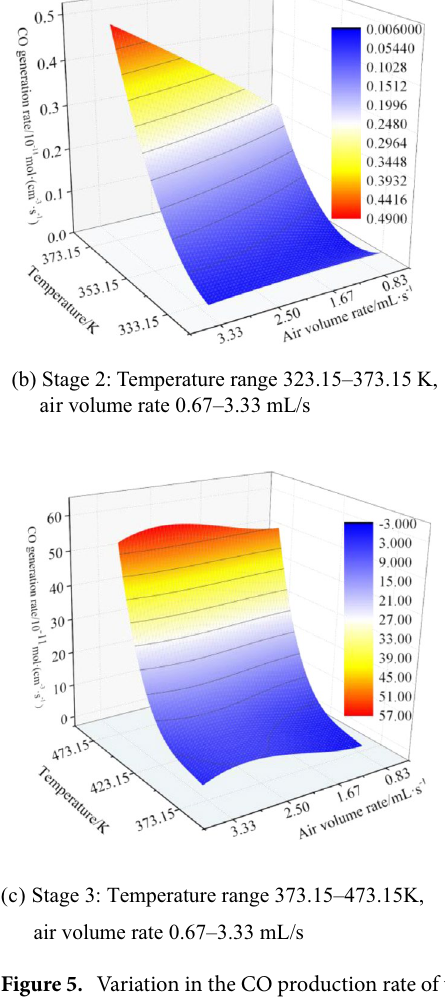
Figure 5. Variation in the CO production rate of the coal samples with temperature and air